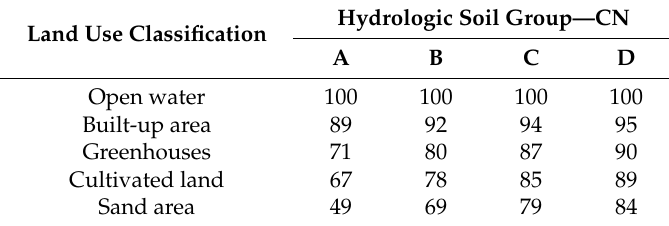
Table 2. Relationship between land use classification, hydrologic soil group and curve number [17].